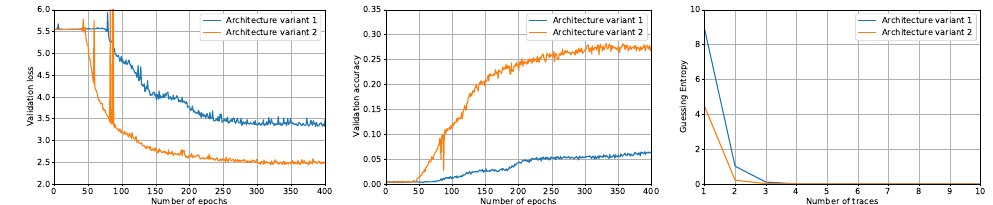
Figure 11: Results of synchronized